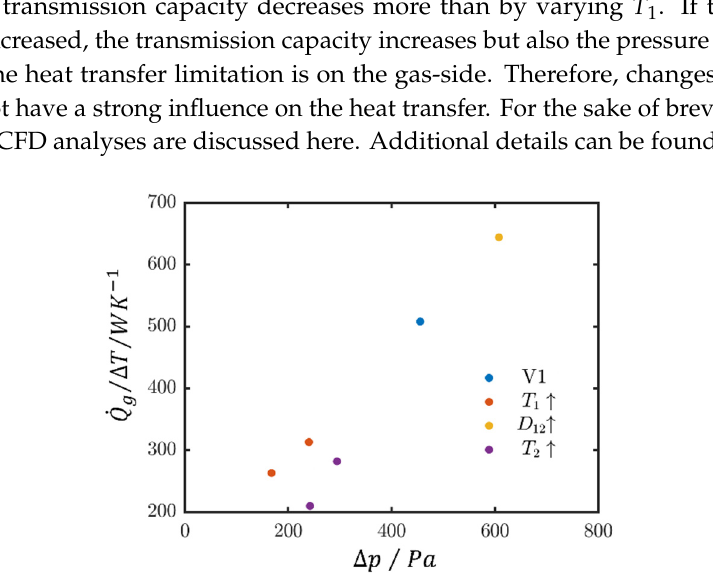
Figure 9. Variation of heat exchanger transmission capacity and pressure drop due to changes of geometric parameters from their baseline values (V1) ((cid:1874) (cid:3034) = 7.0 m s⁄ ) .